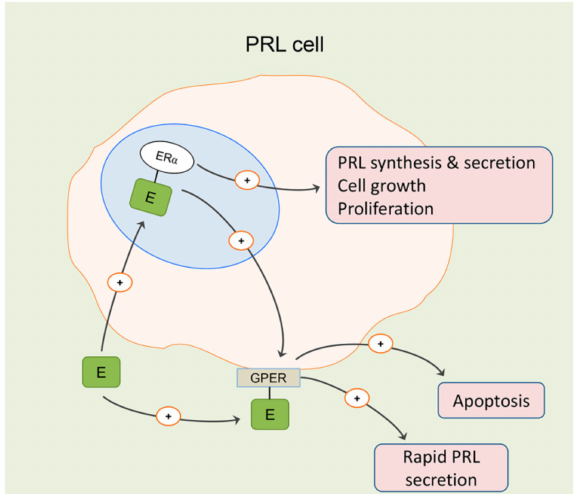
Figure 3. Physiological and pathophysiological mechanisms of estrogen (E) action on proliferation, growth and secretion of lactotropic (PRL) cells are probably largely mediated by nuclear estrogen receptor (ER) α . Membrane G-protein-coupled estrogen receptor 1 (GPER)-mediated estrogen signaling seems to be more involved in antiproliferative and apoptotic actions in the pituitary and may contribute to rapid secretion of PRL under physiological conditions. Its expression is under ER α -mediated nuclear signaling